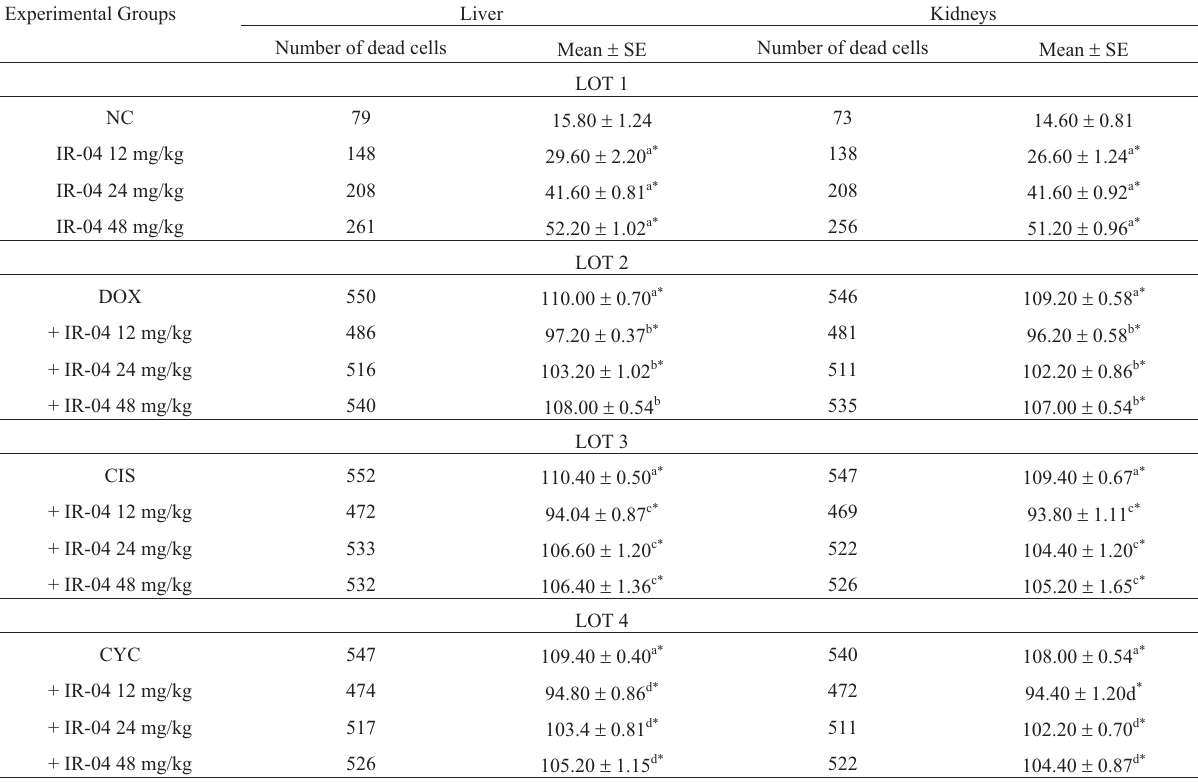
Table 3 - Cell death evaluation on mice’ kidneys and liver. Experimental